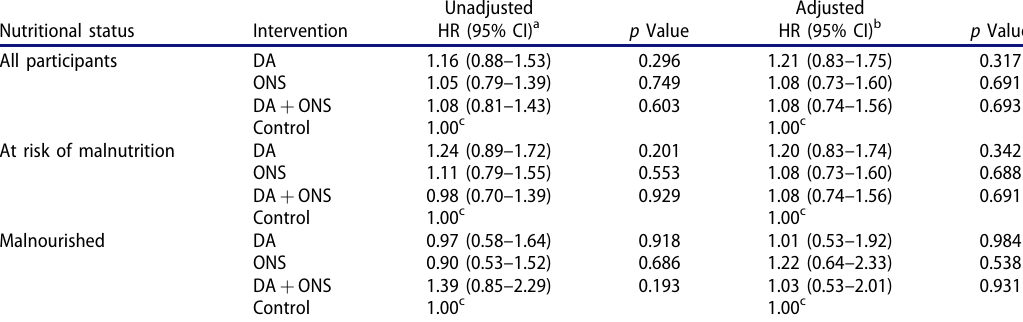
Figure 4. Kaplan – Meier survival curves for malnourished participants in the four intervention groups ( n ¼ 165). Log-rank test for any difference between groups ( p ¼ 0.298). DA: dietary advice; ONS: oral nutritional Table 3. All-cause mortality for the three interventions and the control group.